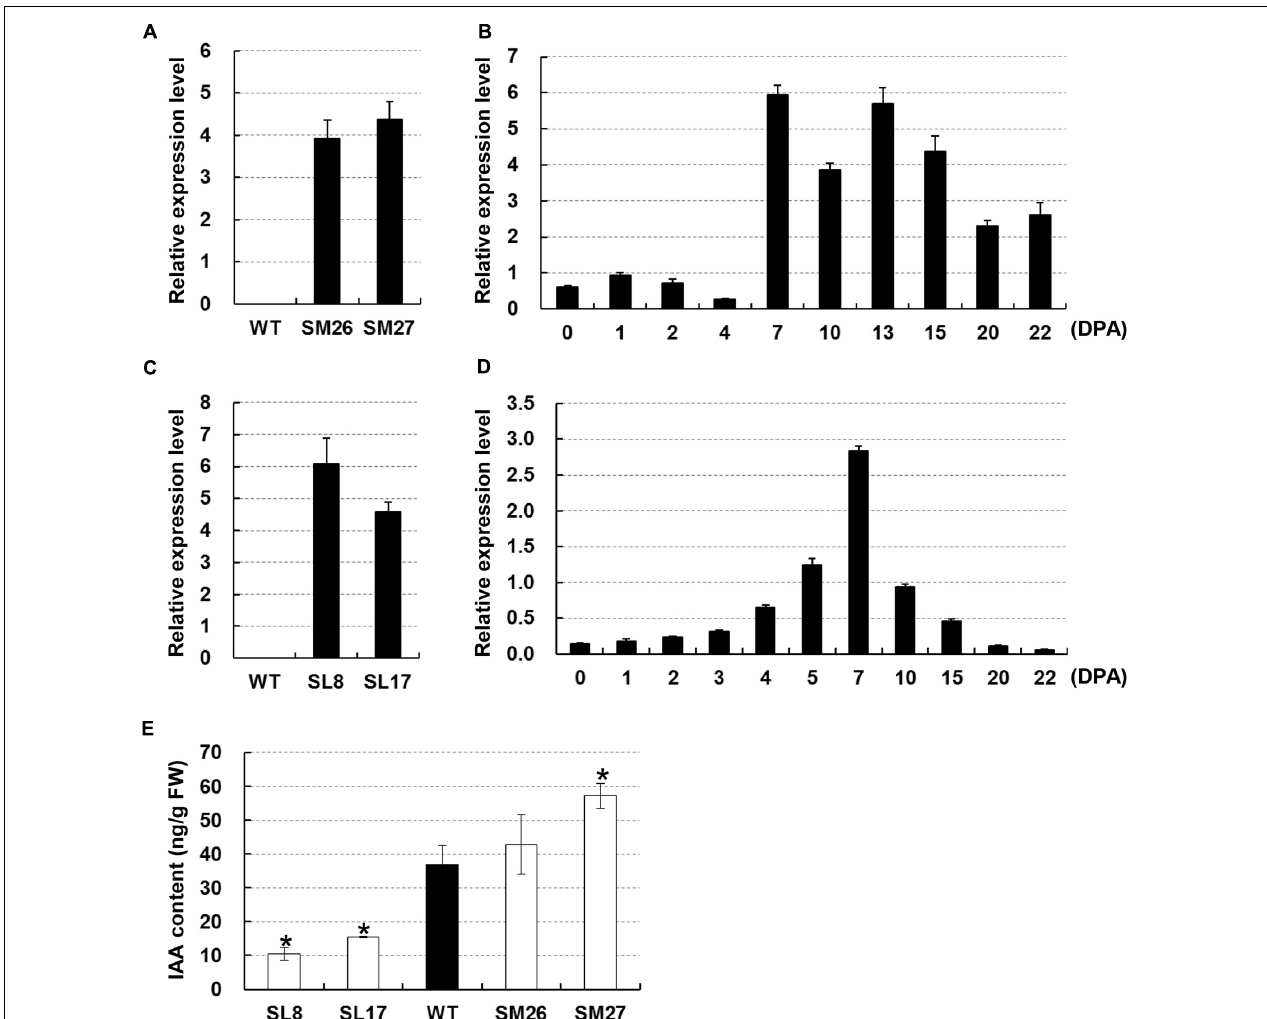
FIGURE 2 | Manipulation of auxin level in cotton fibers. (A) Expression of iaaM in 15-DPA fibers of SCFP:iaaM cotton. (B) Expression of iaaM in developing ovules and fibers of SCFP:iaaM cotton. (C) Expression of iaaL in 15-DPA fibers of SCFP:iaaL cotton. (D) Expression of iaaL in developing ovules and fibers of SCFP:iaaL cotton. (E) Free indole acetic acid (IAA) content in wild-type and transgenic cotton fibers at 15 DPA. Error bars indicate standard deviation of three biological replicates. Wildtype in (A) and (C) was used as negative control. SM, SCFP:iaaM transgenic cotton; SL, SCFP:iaaL transgenic cotton; WT, wild-type; DPA, day post-anthesis. Asterisks indicate significant difference as determined by Student’s t -test ( P <